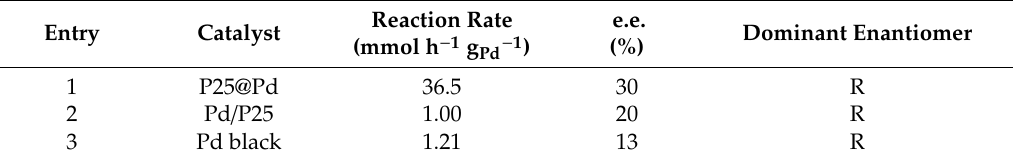
Reaction conditions: 273 K, 7 mg of catalyst, 20 μL of acetophenone, 400 mg of S-proline, 17 mL of methanol, and H 2 (60 mL·min −1 ).